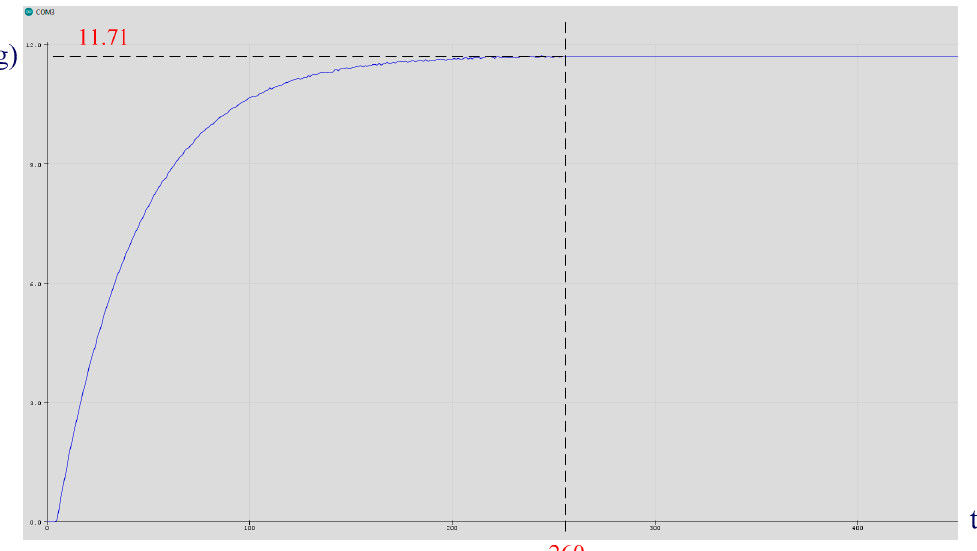
Figure 14. Milk weight change of cow, C_10, versus time plot.